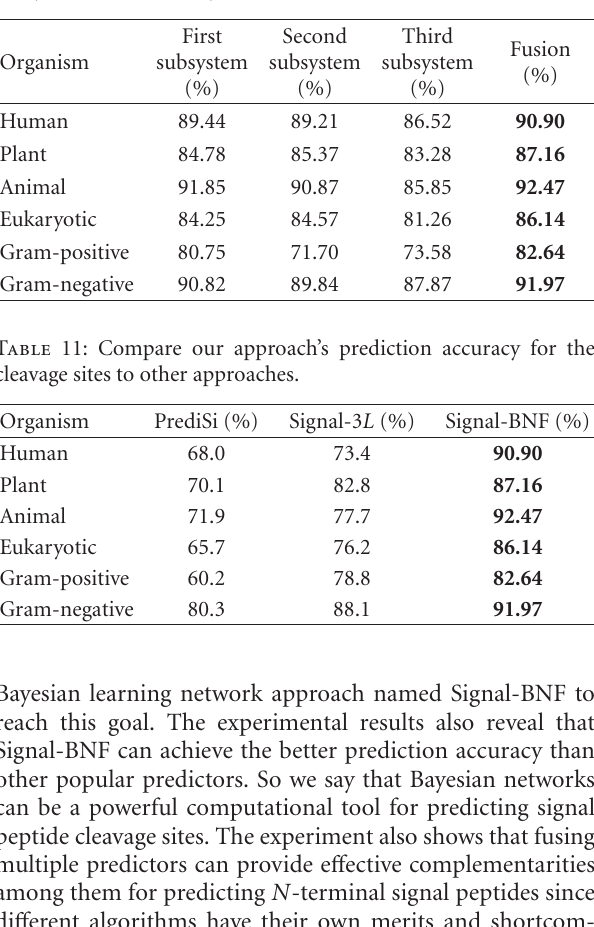
Table 10: The prediction accuracy for the cleavage sites by three subsystems and fusion system.